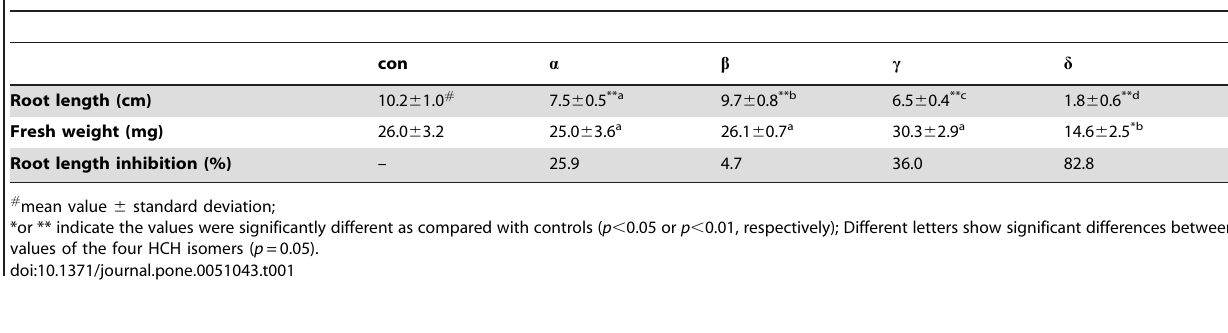
Table 1. Changes of root length and fresh weight in Arabidopsis thaliana exposed to a -, b -, c - and d -HCH for four weeks.